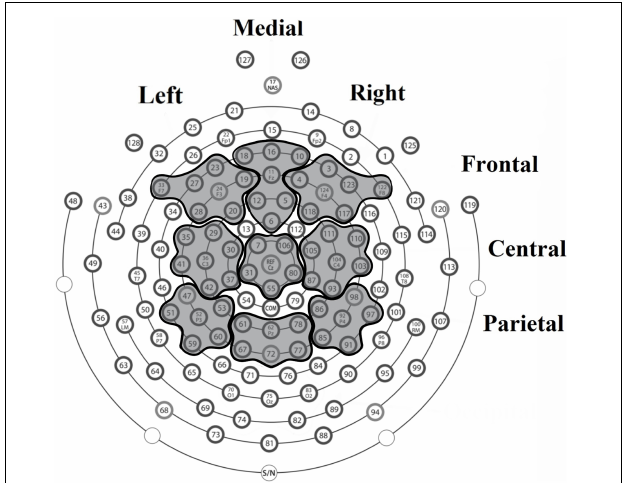
FIGURE 2 | Electrode arrangement used for amplitude and latency analyses of ERP components.